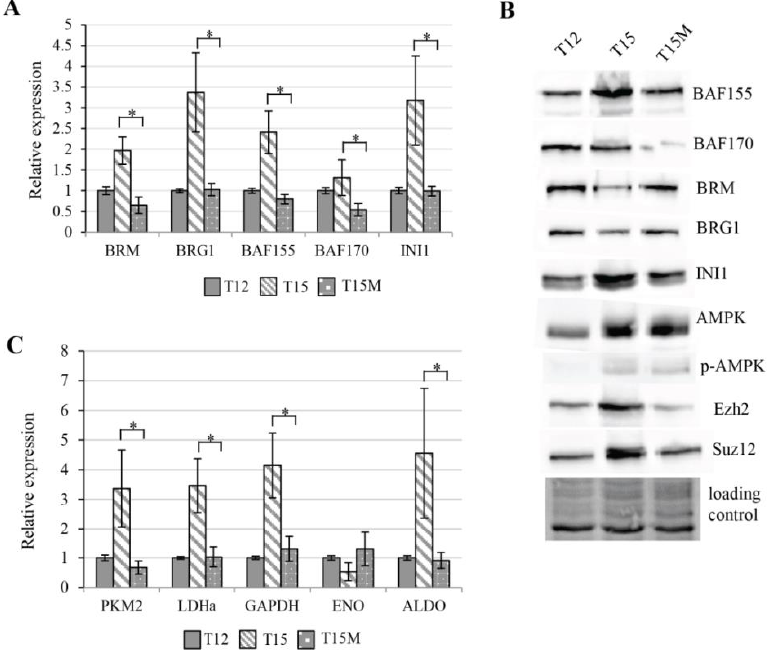
Figure 4. Cancer cells affect chromatin remodeling and glucose-metabolism-related genes in persis- tently activated CD4+ T cells: ( A ) expression levels of genes encoding SWI/SNF CRCs subunits in restimulated CD4 + T cells depend on the presence of cancer cells and are elevated in restimualted CD4 + T cells growing without cancer cells (T15); ( B ) protein abundance levels of SWI/SNF CRC and PRC2 core subunits, as well as key the metabolism controller AMPK, are affected in restimulated CD4 + T cells by the presence of cancer cells (T15M sample); ( C ) cancer cells affect the expression of metabolism related genes in restimulated CD4 + T cells (T15M) compared to restimulated CD4 + T cells (T15). ( A , C ) The data from 3 independent biological replicates (donors) are presented, the statistical significance of which was calculated using Student’s t -test p < 0.05, with the statistically significant values being indicated by asterisks. The uncropped blots and molecular weight markers are shown in Supplementary Materials.